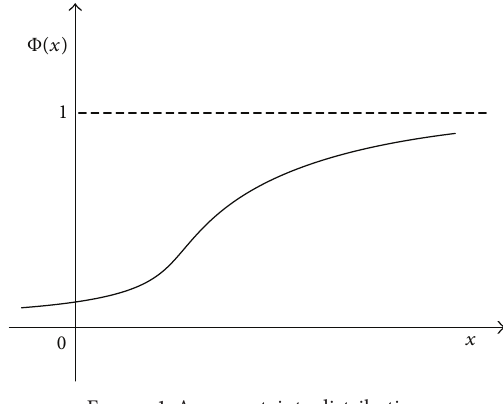
Figure 1: An uncertainty